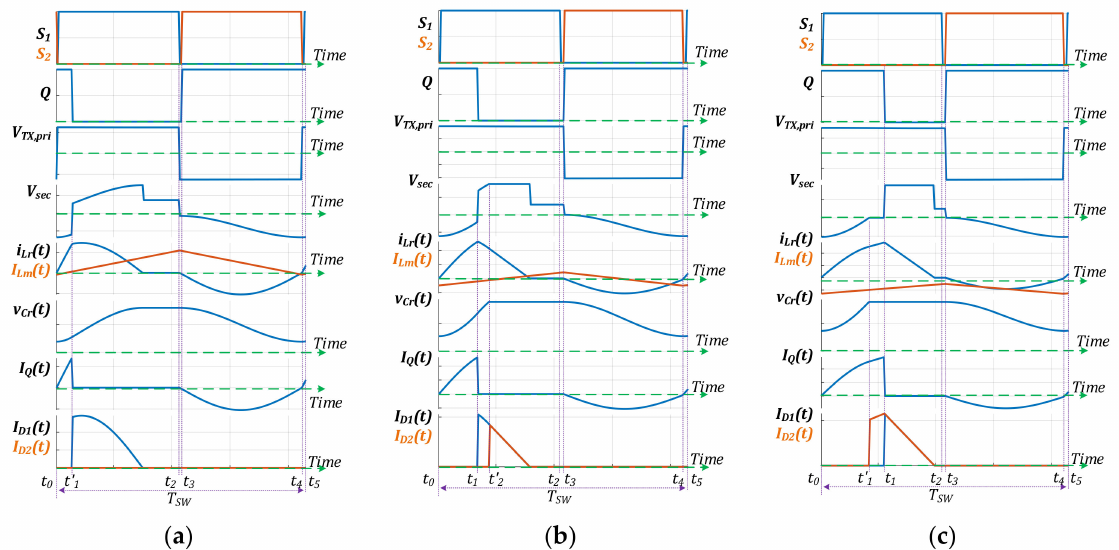
Figure 4. Steady-state waveforms of the proposed converter for three operation scenarios in the boost - SRC condition.